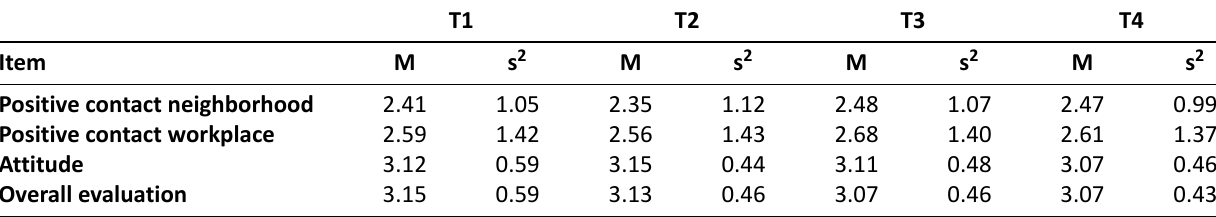
Table 4. Descriptive statistics on positive and negative intergroup contact and attitudes for foreigners for all four waves of the GESIS Panel. Source: GESIS